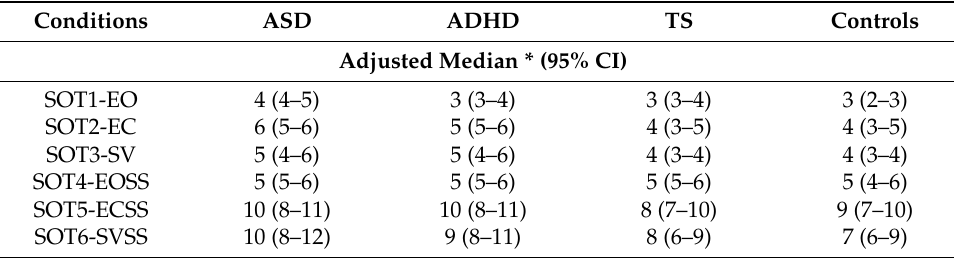
Table 5. Performance in the Lateral Average Velocity (LAV) parameter among NDD conditions and